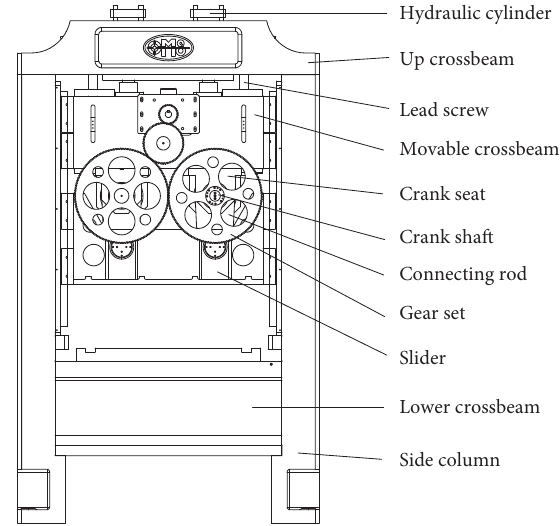
Figure 1: High-speed precision servo punching